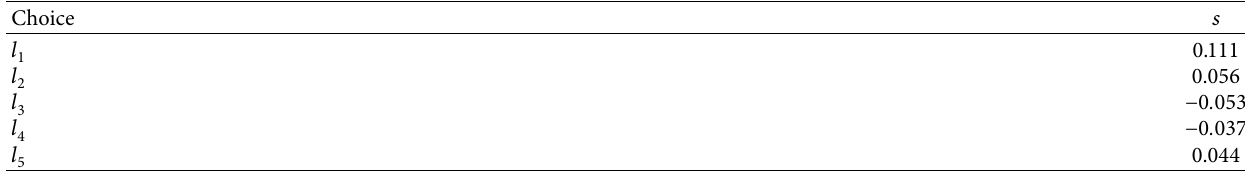
Table 9: Values of SP m FWA ( O